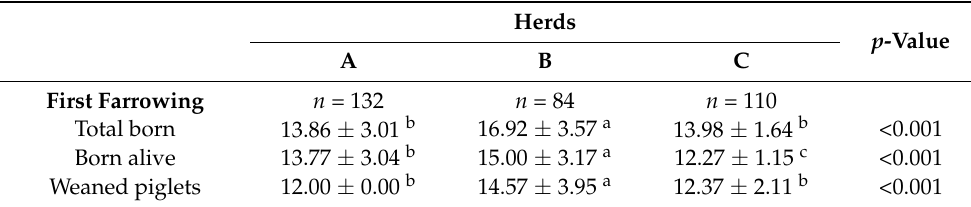
Table 9. Average values of total born, born alive and weaned piglets at first and second farrowing in sows of different genetic lines in three farrow-to-finish herds in Greece. Herds p -Value A